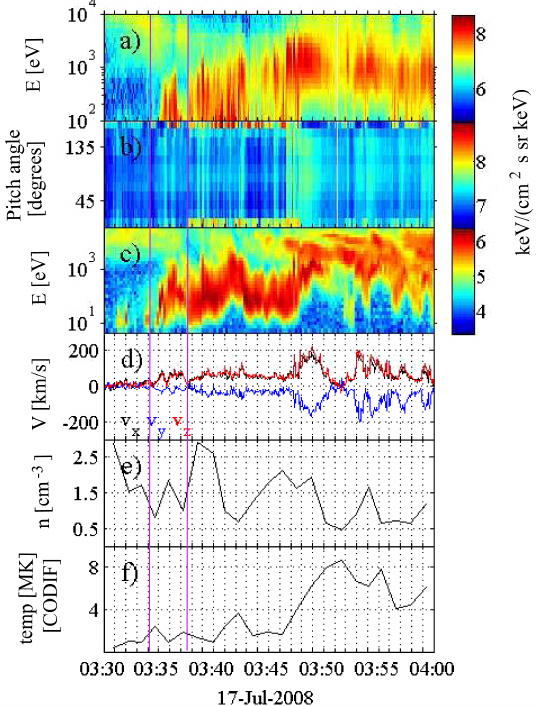
Figure 6. Cluster 3 on 17 July 2008: (a) electron spectrogram, (b) pitch angle distribution of electrons, (c) ion spectrogram, (d) ion velocity in GSE, (e) ion density, (f) parallel (to mag. field) tempera- ture. Two violet lines mark the cusp